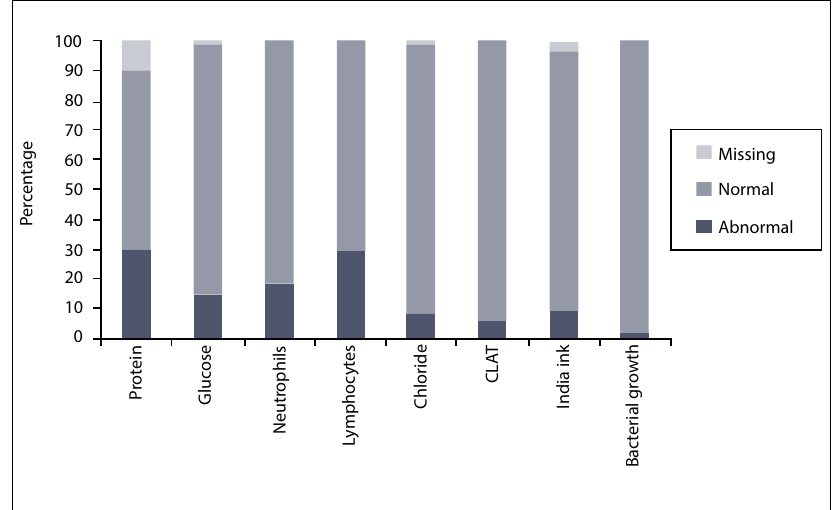
Fig. 2. Percentage of patients with abnormal CSF. (CSF = cerebrospinal fluid; CLAT = cryptococcal latex antigen Table 3. Univariate and multivariate analyses of potential predictors of abnormal CSF results Unadjusted